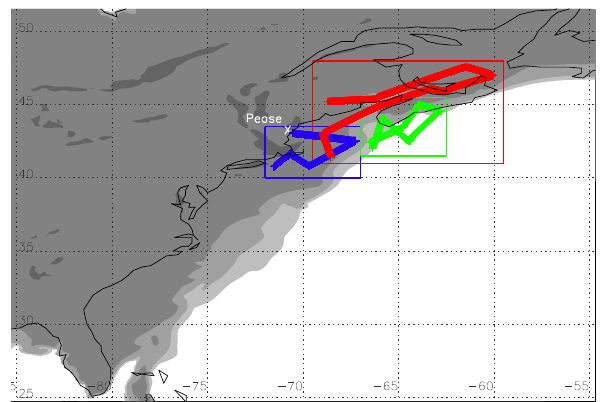
Figure 1. Tracer mixing ratio (shading) at 20:00UTC on 20 July 2004, integrated from 20 to 1620m a.s.l. Each shade represents a Fig. 1. Tracer mixing ratio (shading) at 20 UTC on 20 July 2004, change in tracer concentration by a factor of 10, with dark grey rep- integrated from 20-1620m above sea level. Each shade represents resenting the highest mixing ratios. The cross marks the location of a change in tracer concentration by a factor of 10 with dark grey the wind profiler at Pease. The coloured lines show the segments representing the highest mixing ratios. The cross marks the location aircraft flights performed on 20 (blue), 21 (green) and 22 July (red) of the windprofiler at Pease. The coloured lines show the segments that intercept the same polluted air mass. The coloured boxes rep- aircraft flights performed on the 20th (blue), 21st (green) and 22nd resent the area over which modelled profiles are calculated for each July (red) that intercept the same polluted air mass. The coloured respective day in Fig. boxes represent the area over which modelled profiles are calculated for each respective day in Fig. 4a.